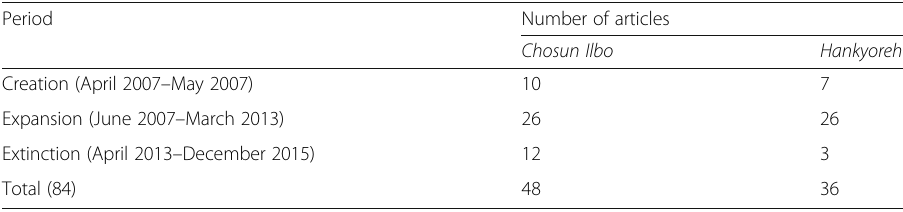
Table 1 Distribution of articles in the three periods